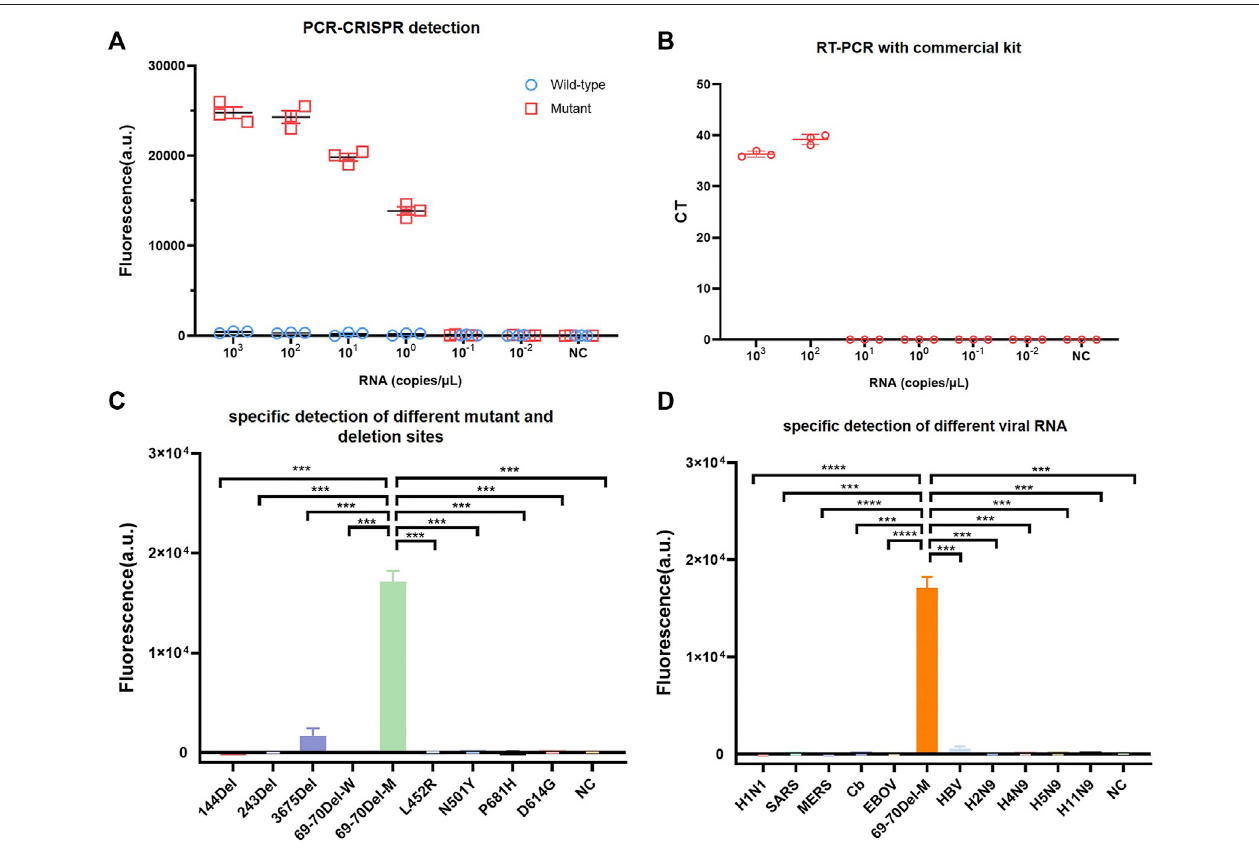
FIGURE 2 | Identifying the sensitivity and speci fi city of PCR-CRISPR detection and comparing sensitivity with other nucleic acid detection tools. (A) Sensitivity detection of wild and mutant templates carried out using PCR-CRISPR and M-crRNA-1. (B) Detection analysis of mutant RNA dilution series with RT-qPCR with a commercial kit. (C) PCR-CRISPR can discriminate different viral mutant or deletion sites. (D) PCR-CRISPR achieves speci fi c detection of different viral RNA. ( n = 3 technical replicates, two-tailed Student t-test; ***, p < 0.001; ****, p < 0.0001; bars represent mean ± s.e.m.).